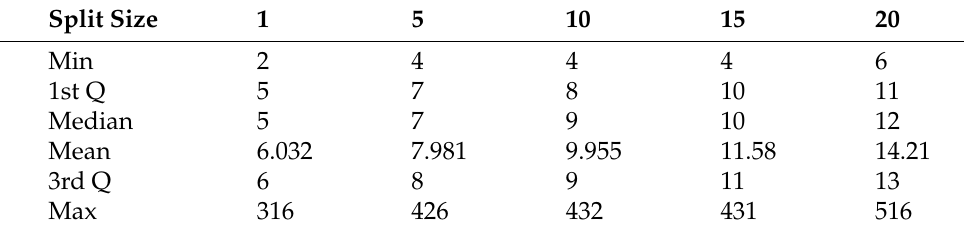
Figure 9. Delay in measurement for off-chain transactions. Table 2. Statistics of consumer delay in Figure 9a.